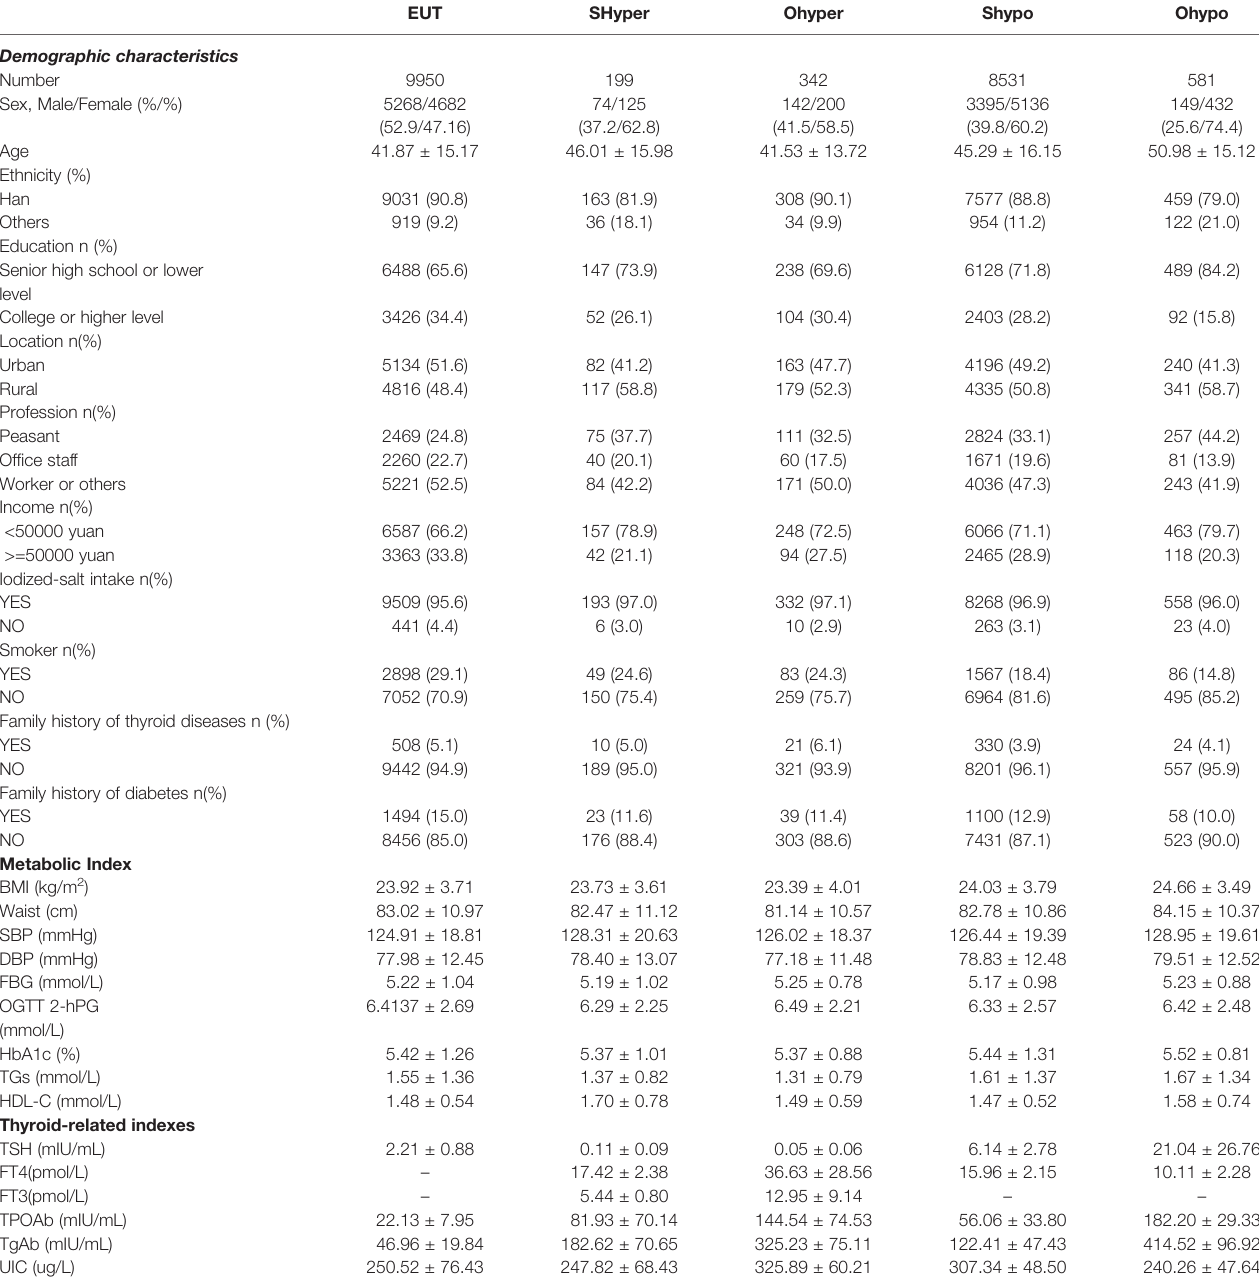
TABLE 1 | General characteristics of participants with different thyroid functional statuses. EUT SHyper Ohyper Shypo